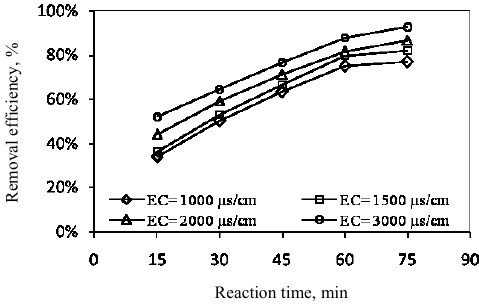
Figure 6. Effect of reaction time on the HA removal efficiency as a function of conductivity